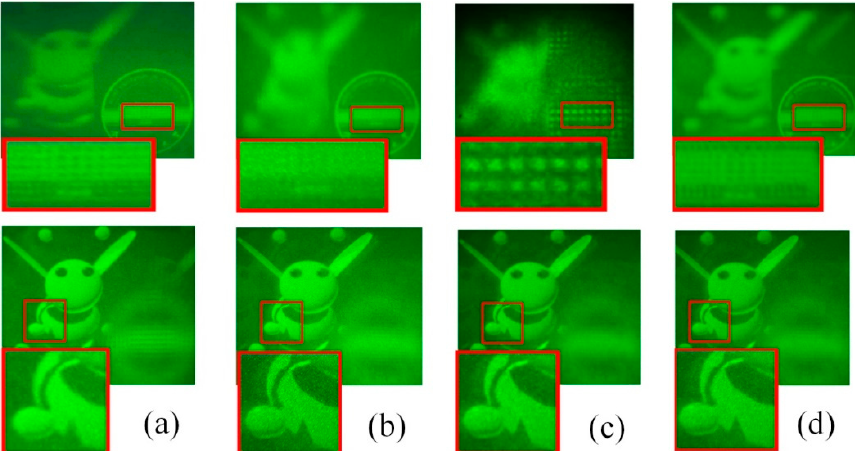
Figure 12. ( a ) Optical reconstruction results with focal length f = 3 mm. ( b ) Optical reconstruction results with focal length f = 6 mm. ( c ) Optical reconstruction results with focal length f = 6 mm and partial aperture filtering. ( d ) Optical reconstruction results with partial aperture filtering and MALT.